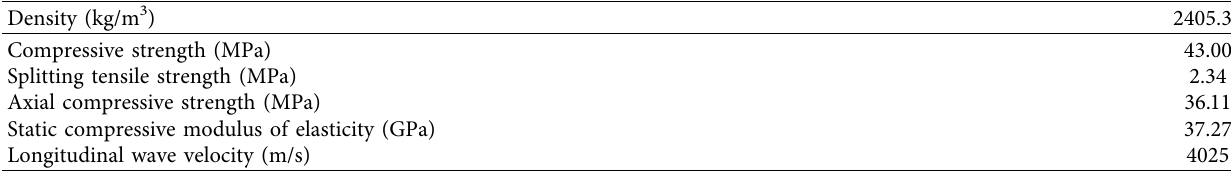
Figure 4: Standard model of concrete test block. (a) Test blocks of 150 mm × 150 mm × 150 mm. (b) Test blocks of 150 mm × 150 mm × 300mm. Table 2: Test results of mechanical properties of ordinary concrete.